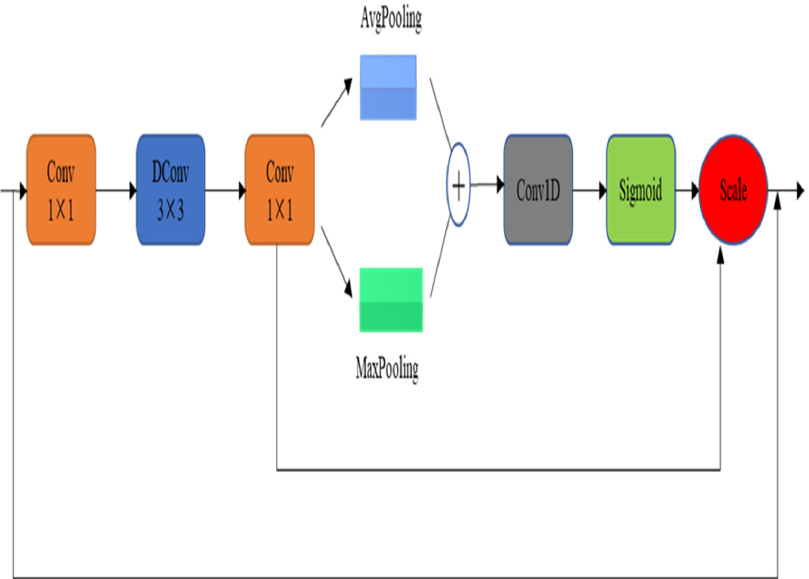
Figure 2. Structure of the DCABlock module for feature extraction and learning. Two pooling layers are used to aggregate the different semantic information.